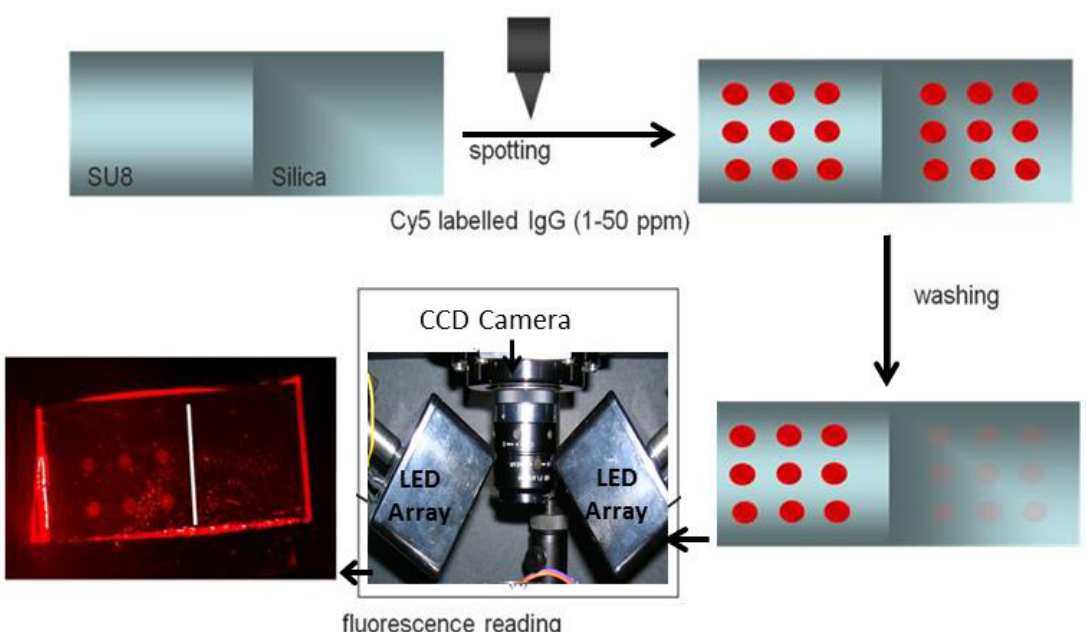
Figure 2. Scheme of the procedure employed to test the selective antibody immobilization on SU-8 planar chips using microarrays and Cy5